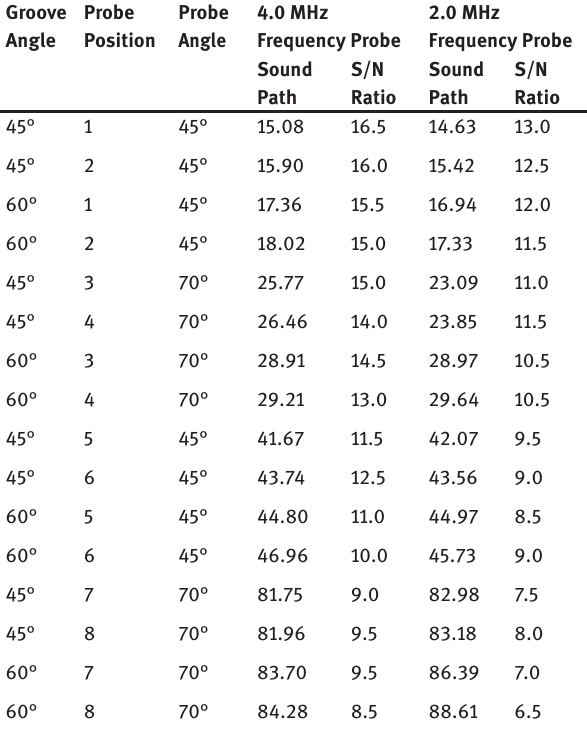
Table 3: Results of Ultrasonic Tests using Transversal Probes. Groove